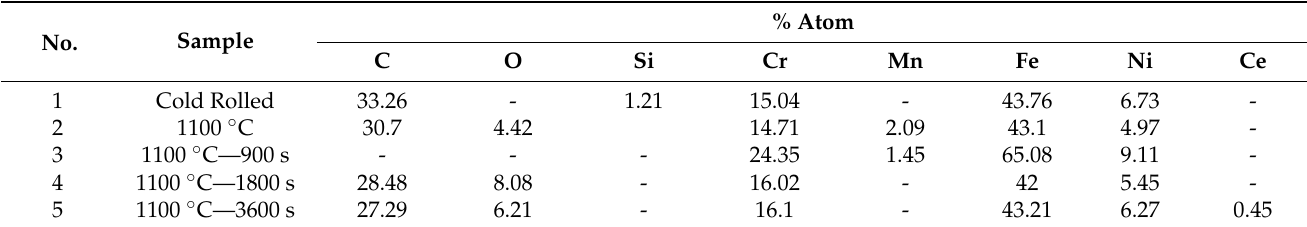
Table 2. EDAX analysis of the precipitates.